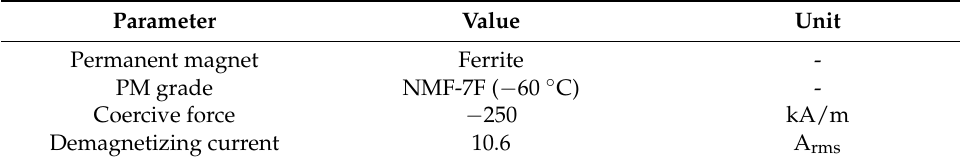
Table 4. Specification for irreversible demagnetization analysis.